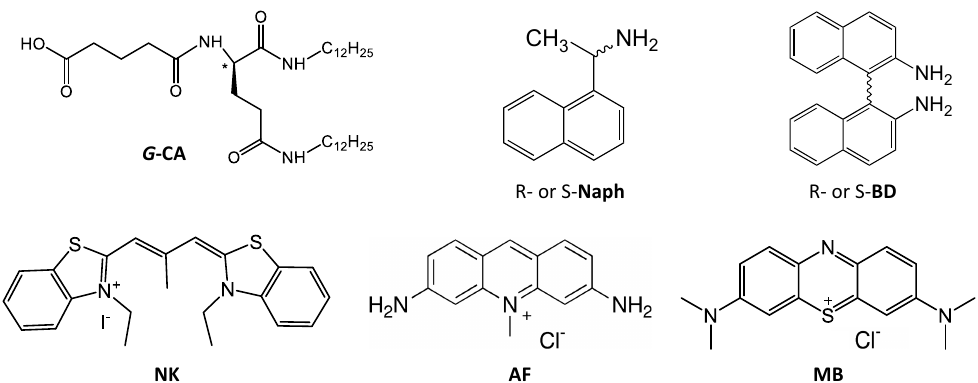
Figure 1. Chemical structures of key materials used in this work. L-glutamic-acid-based organogelator ( G -CA): L-glutamic-acid-based organogelator; NK, AF, and MB: cyanine dye NK-77, acryflavine, and methylene blue as cationic fluorescent dyes, respectively; Naph and BD: 1-naphthylethylamine and binaphthyl-2,2’-diamine, respectively.